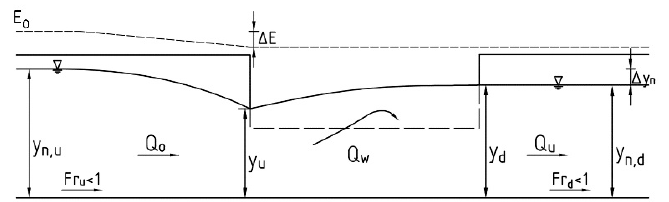
Figure 1. Water surface (represented by flow depth y ) and energy line (parameter E ) in a one-dimensional approach at a side weir at subcritical flow conditions (modified after De Marchi [2]); flow direction from left to right.